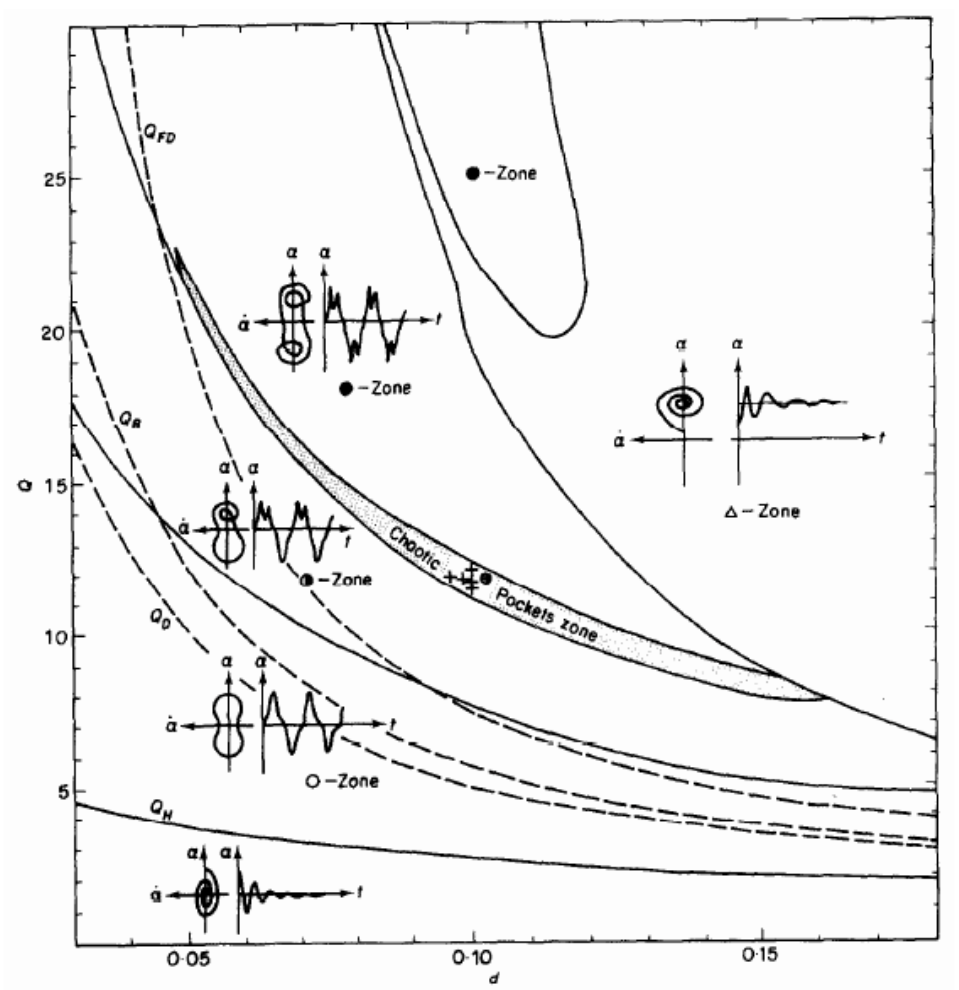
Figure 2. (Q, d) parameter plane with boundaries for different types of motion [1].